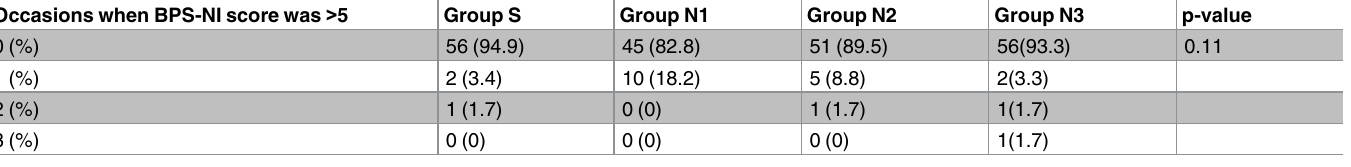
Table 3. Occasions when the modified BPS-NI score was more than 5 during colonoscopy. Occasions when BPS-NI score was >